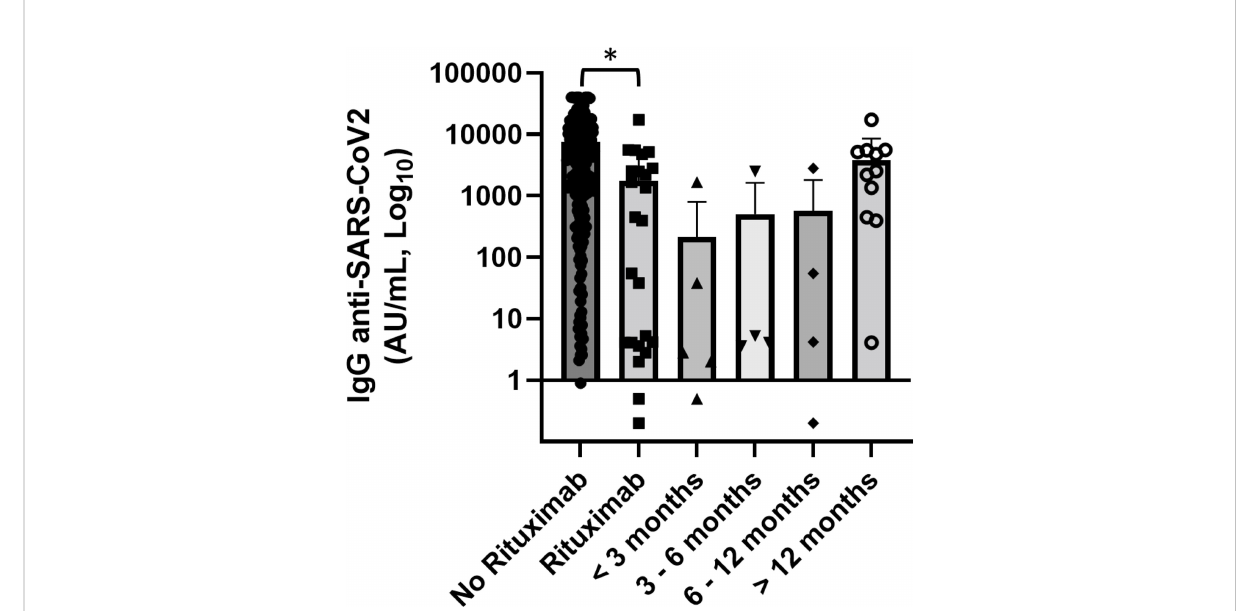
FIGURE 5 Association of anti-SARS-CoV2 IgG concentrations with anti-CD20 therapy and distance from the end of anti-CD20 treatment. Patients treated with rituximab (n = 30) showed signi fi cantly lower levels of anti-SARS-CoV-2 IgG than patients did not receive anti-CD20 treatment. Differences assessed by one-way ANOVA test (p = 0.003), Bonferroni post-hoc test: (*) p < 0.05. Error bars correspond to standard deviation calculated from the mean of relative concentrations. Values below the black line correspond to anti-SARS-CoV-2 IgG lower than 10.0 AU/ml, and values of 0 AU/ml were not shown since the graph is on a log scale.